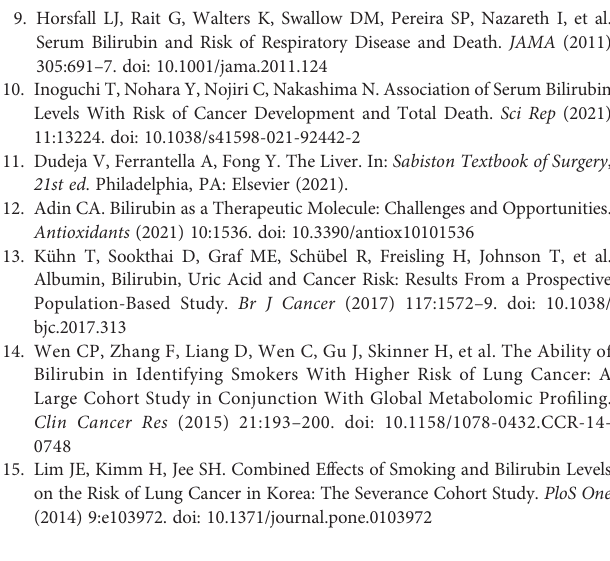
Supplementary Figure 1 | Association of serum levels of total bilirubin and albumin with lung cancer risk. Supplementary Table 1 | Association of serum levels of total bilirubin/albumin ratio with lung cancer